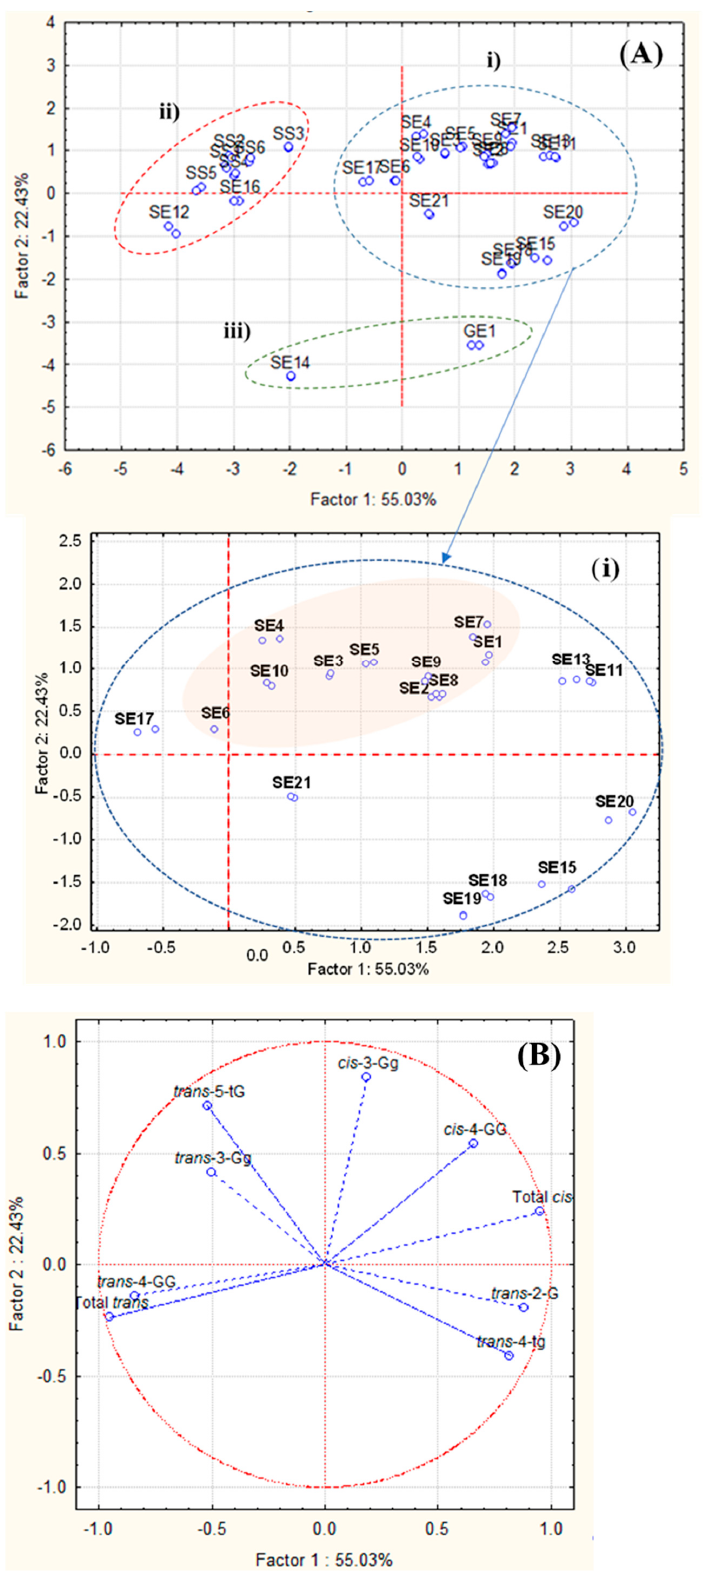
Figure 4. ( A ) Principal component analysis (PCA) biplot of crocin data obtained by HPLC-DAD for commercial saffron extracts (SE), stigmas (SS) and gardenia (GE) under study. ( B ) Projection of the variables on the factor plane (factor 1 vs. factor